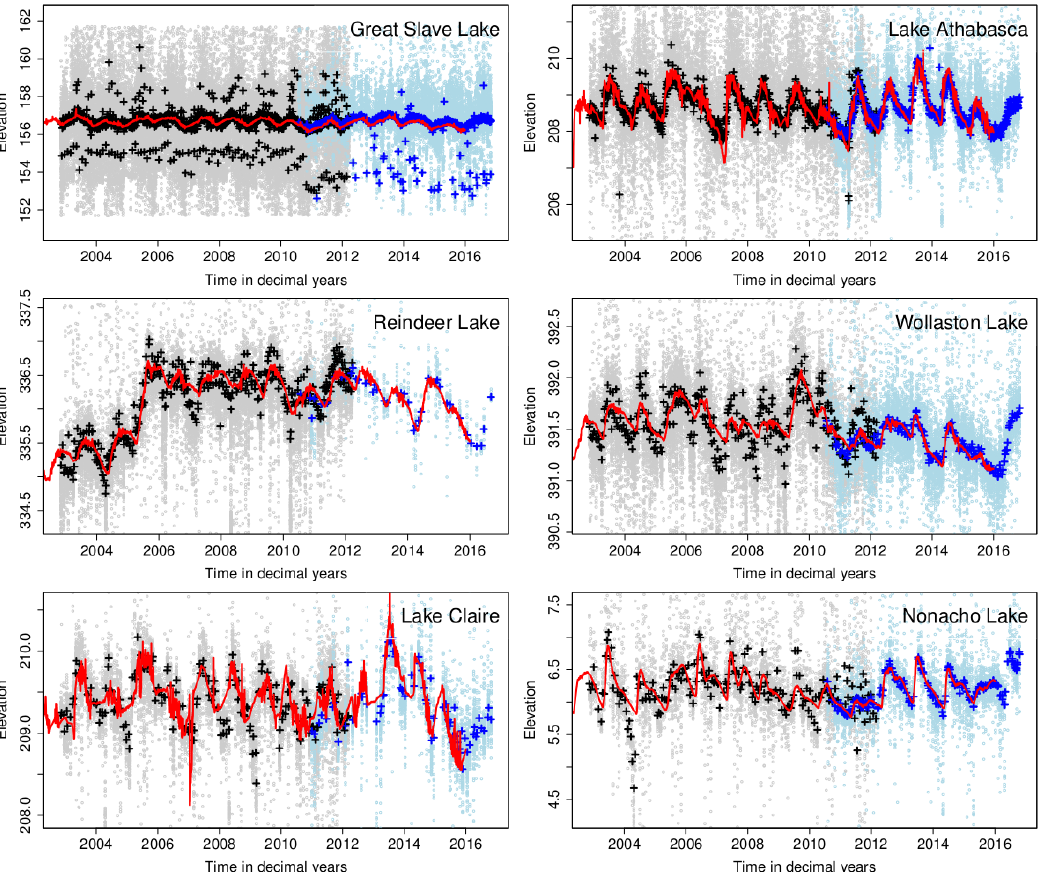
Figure 6. Water level time series for the six Canadian lakes; Great Slave, Athabasca, Wollaston, Claire, Nonacho, Reindeer. The gray (Envisat) and blue (CryoSat-2) circles represent the raw retracked water levels. The black (Envisat) and blue (CryoSat-2) crosses represent the predicted water level, and the red line is the in-situ water levels.